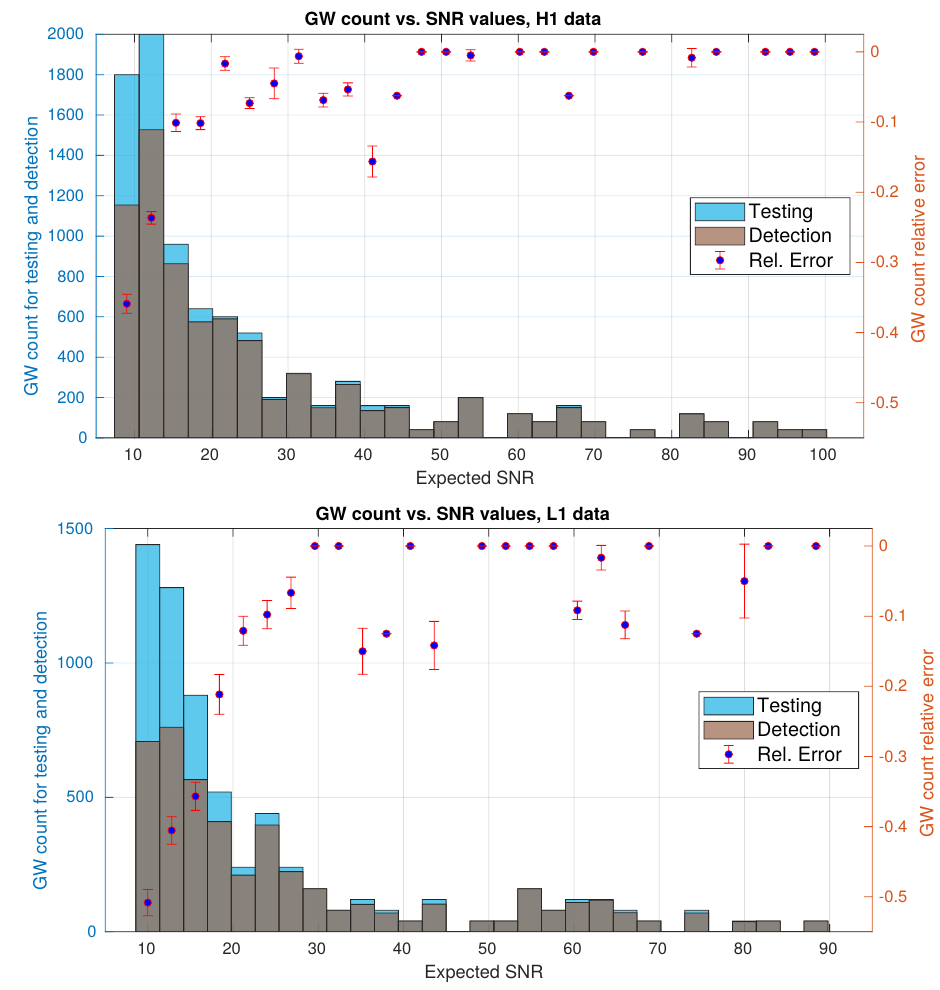
Figure 10. Histograms for counting GW samples present in test set and GW samples detected by the CNN. This count was made from all 100 N test predictions because we have 10 10 = 100 SGD × learning-testing runs. Besides, the relative error between both histograms is shown as scatter points, with their respective standard deviations being computed from the 10 repetitions of the 10-fold CV routine. From plots, we have that our CNN detects more CBC GW events insofar as they have a 21.80 for H1 data (upper panel) and SNR 26.80 for L1 data (bottom SNR ≥ ≥